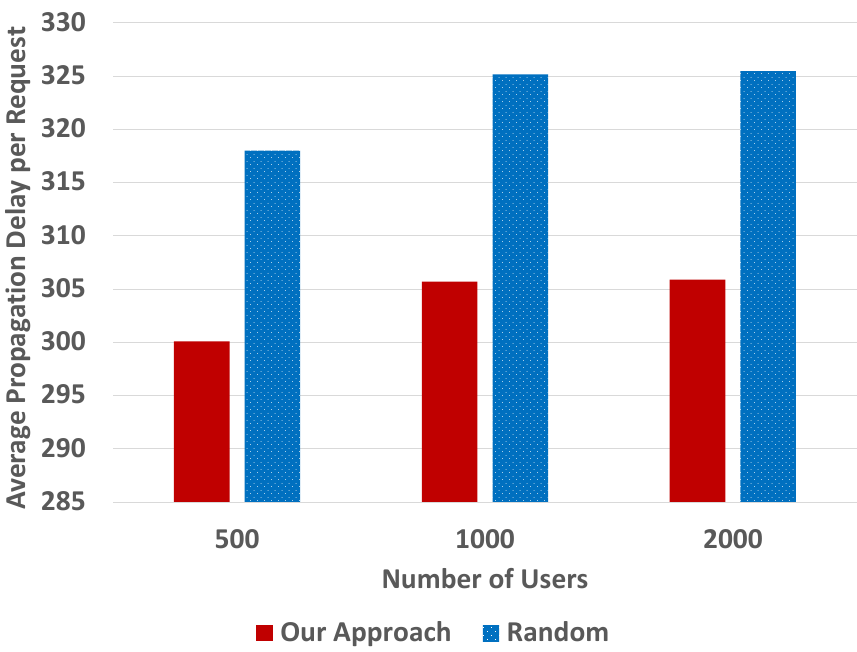
Figure 10. Average propagation delay per request (normalized): 16 regions, 1024 drives per location.